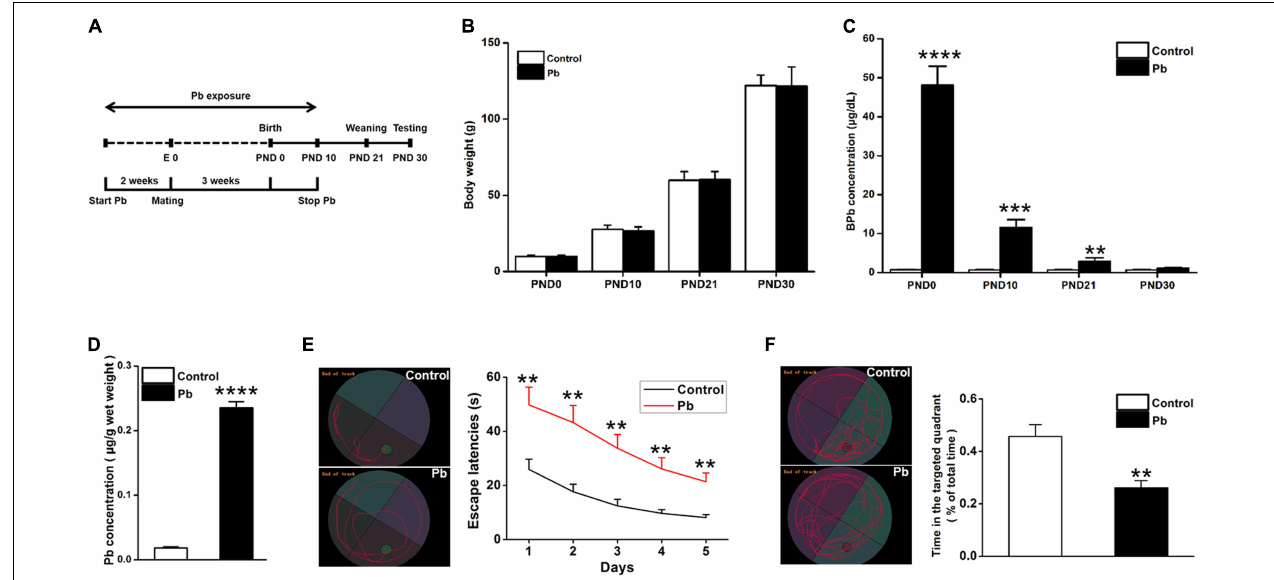
FIGURE 1 | Accumulation of Pb in the hippocampus of PND30 rats and its influence on learning and memory. (A) Establishment of Pb exposure model. Female SD rats were given Pb acetate solutions to drink (0 or 0.02%) beginning 2 weeks before mating until PND 10. (B) Body weights and (C) Blood Pb levels. The concentration of blood Pb in the experimental rats was measured at PND 0, 10, 21, and 30. (D) Pb levels in the hippocampus region. (E,F) Analysis of MWM results. The MWM tests were only measured at PND30. Data are expressed as mean ± SE, ** p < 0.01, *** p < 0.001, **** p < 0.0001; n = 6 per group.